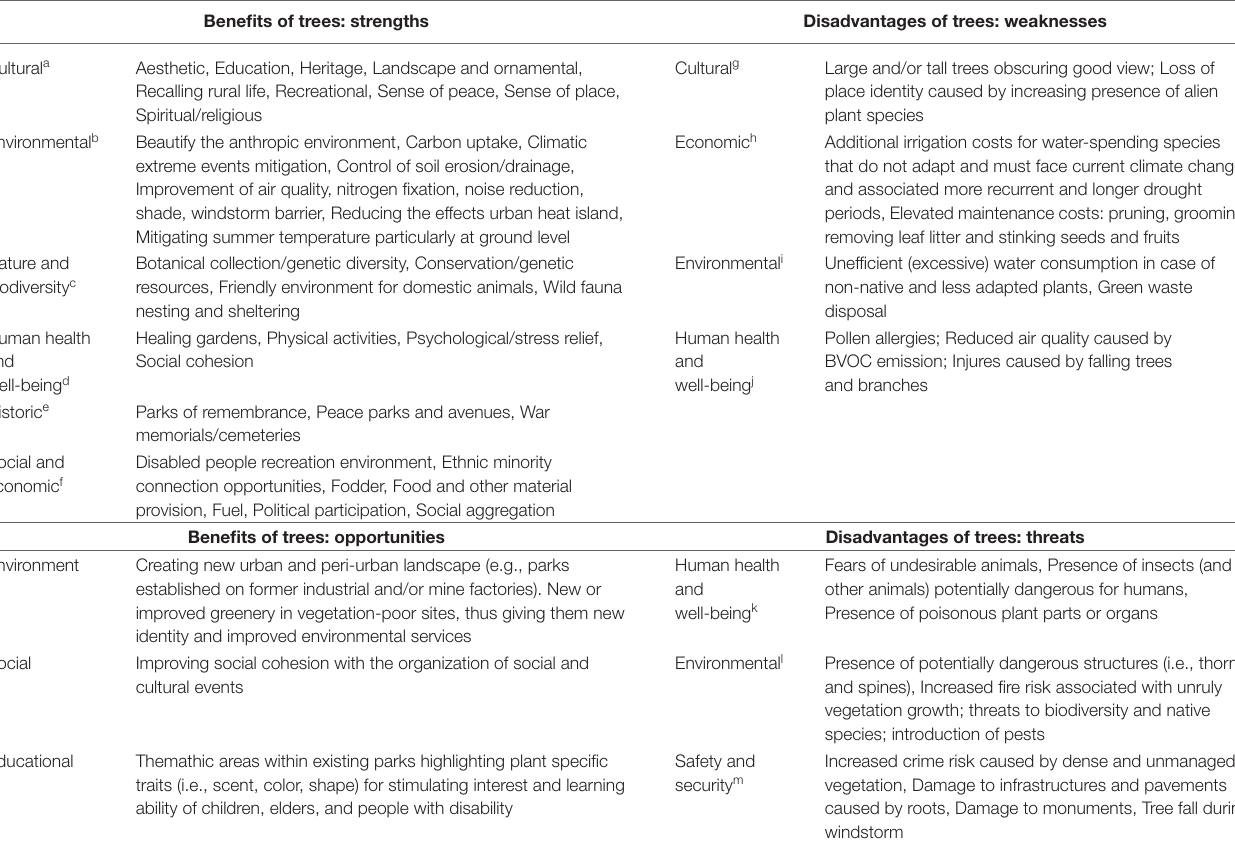
TABLE 1 | A SWOT (strengths, weaknesses, opportunities, and threats) analysis of plants in urban areas. Benefits of trees: strengths Disadvantages of trees: